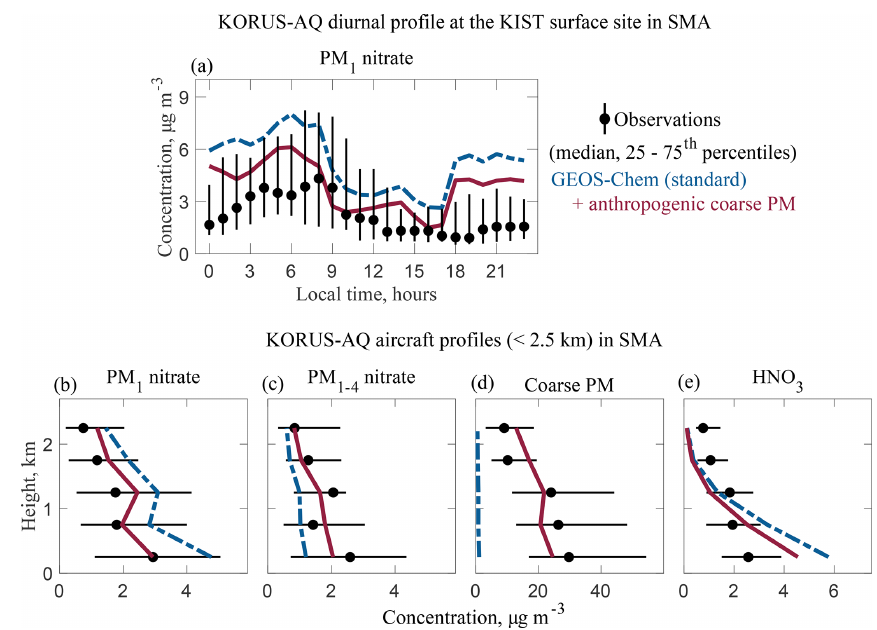
Figure 4. Effect of anthropogenic coarse PM on nitrate concentrations over the Seoul Metropolitan Area (SMA) during the KORUS-AQ campaign (May–June 2016). GEOS-Chem model results without (standard) and with anthropogenic coarse PM are compared to surface and aircraft observations. (a) Median diurnal variation (error bars are 25th and 75th percentiles) of non-refractory PM 1 nitrate (taken to be ammonium nitrate) at the Korea Institute of Science and Technology (KIST) site. (b–e) Median vertical profiles of non-refractory PM 1 nitrate, PM 1–4 nitrate, coarse PM (PM 2 . 5–10 ), and HNO 3 concentrations for the ensemble of flights over the SMA. Horizontal bars for the observations indicate 25th–75th